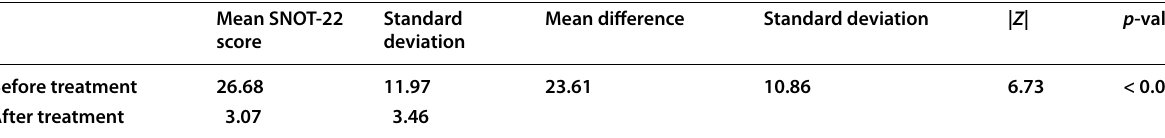
Table 2 Mean SNOT-22 score before and after treatment in group B